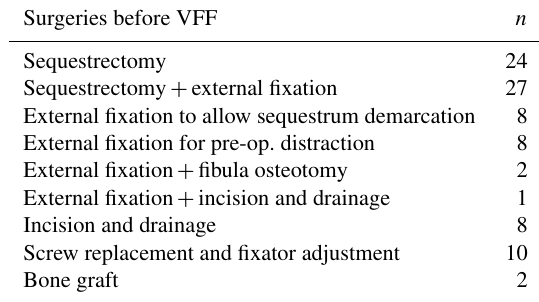
Table 1. Cohort characteristics. Table 2. Procedures performed before VFF.